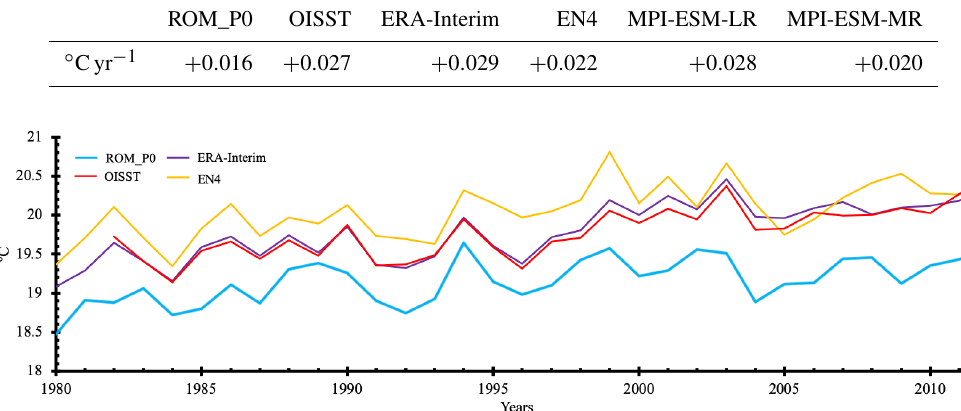
Figure 7. Time series of yearly mean (1980–2012) SSTs ( ◦ C) averaged over the Mediterranean basin. ROM_P0 (blue), OISST (red), ERA- Interim (purple) and EN4 (yellow).